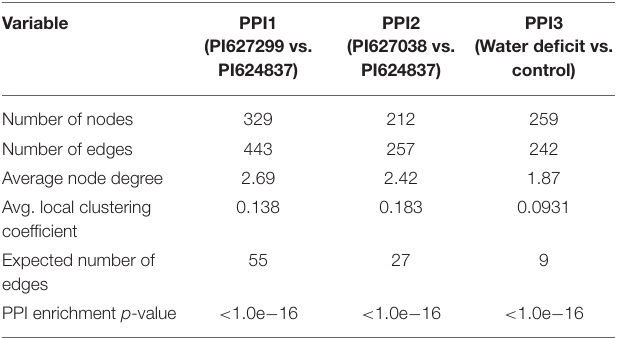
TABLE 3 | PPI network statistics specified to tolerant genotypes and water deficit conditions.